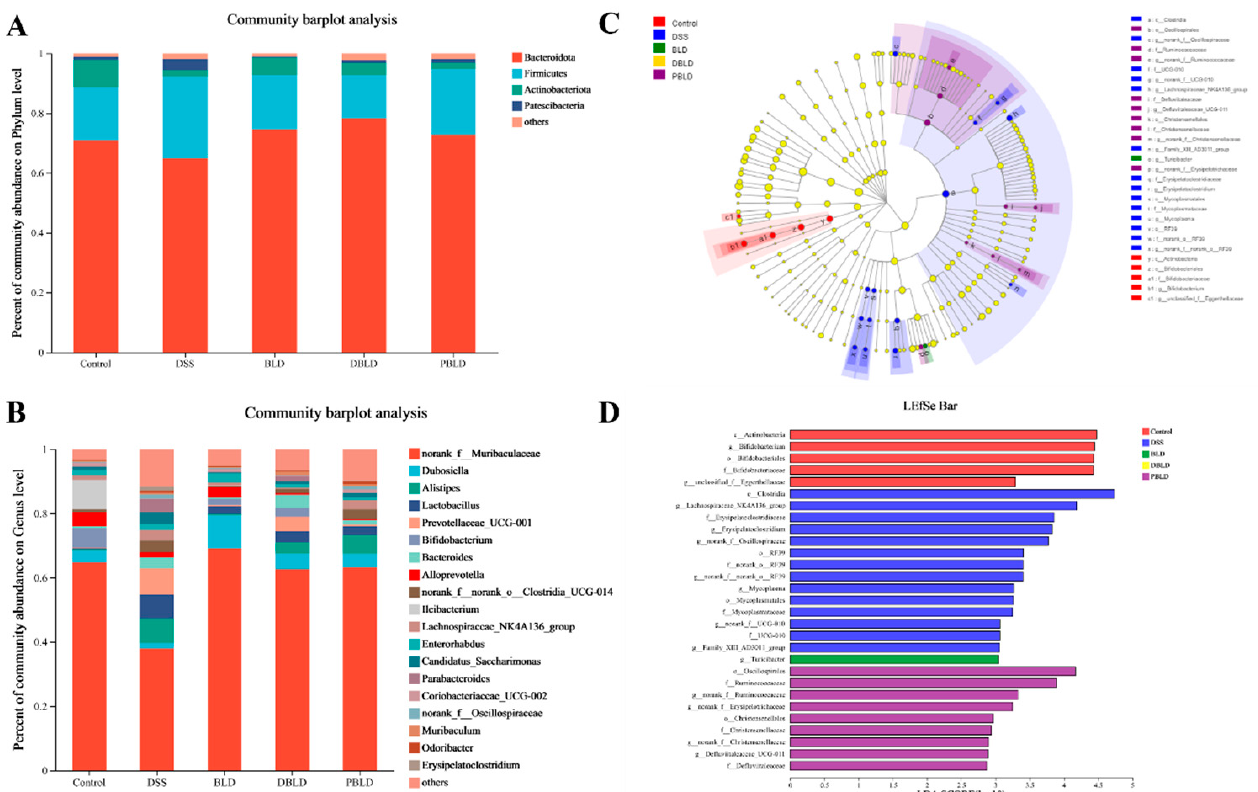
Figure 7. Analysis of the composition of the gut microbial community. ( A ) Composition of the gut flora at the portal level. ( B ) Composition of the gut flora at the genus level. ( C ) LEfSe Cladogram (the rings, from outer to inner, represent genus, family, order, class, and phylum). ( D ) Indicator bacteria with LDA scores of >2 in five